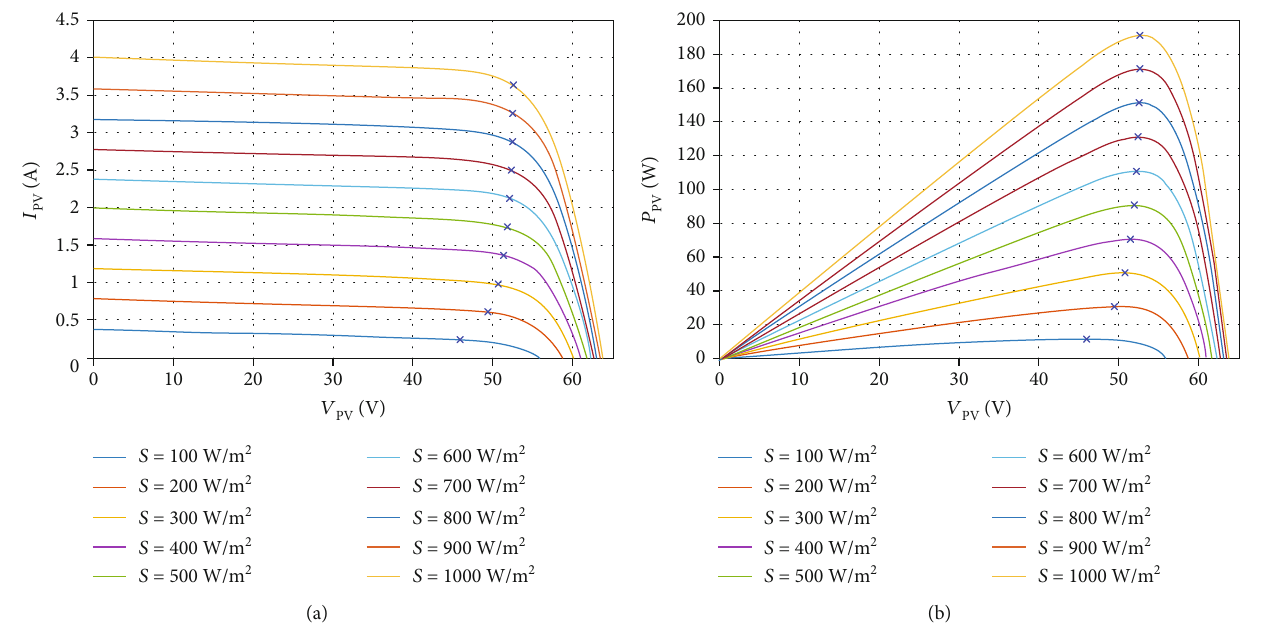
Figure 2: I ‐ V and P ‐ V curves for di ff erent values of solar irradiation: (a) I ‐ V curves; (b) P ‐ V curves.